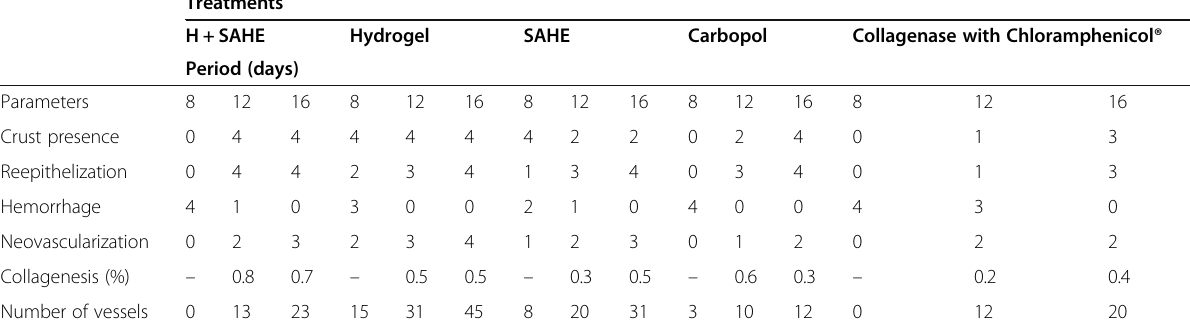
Table 2 Histological Parameters of the Controls Rats